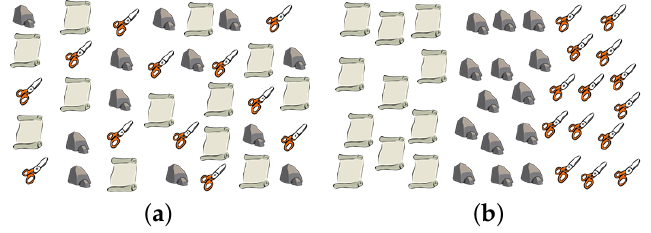
Figure 2. ( a ) Classic population structure approach; ( b ) More realistic population